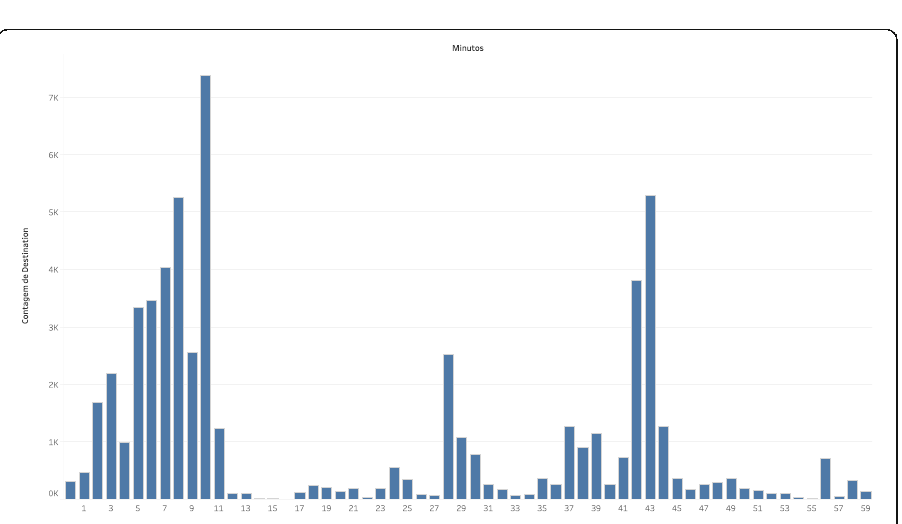
Fig. 4 Use of Facebook per hour in Scriptwriting